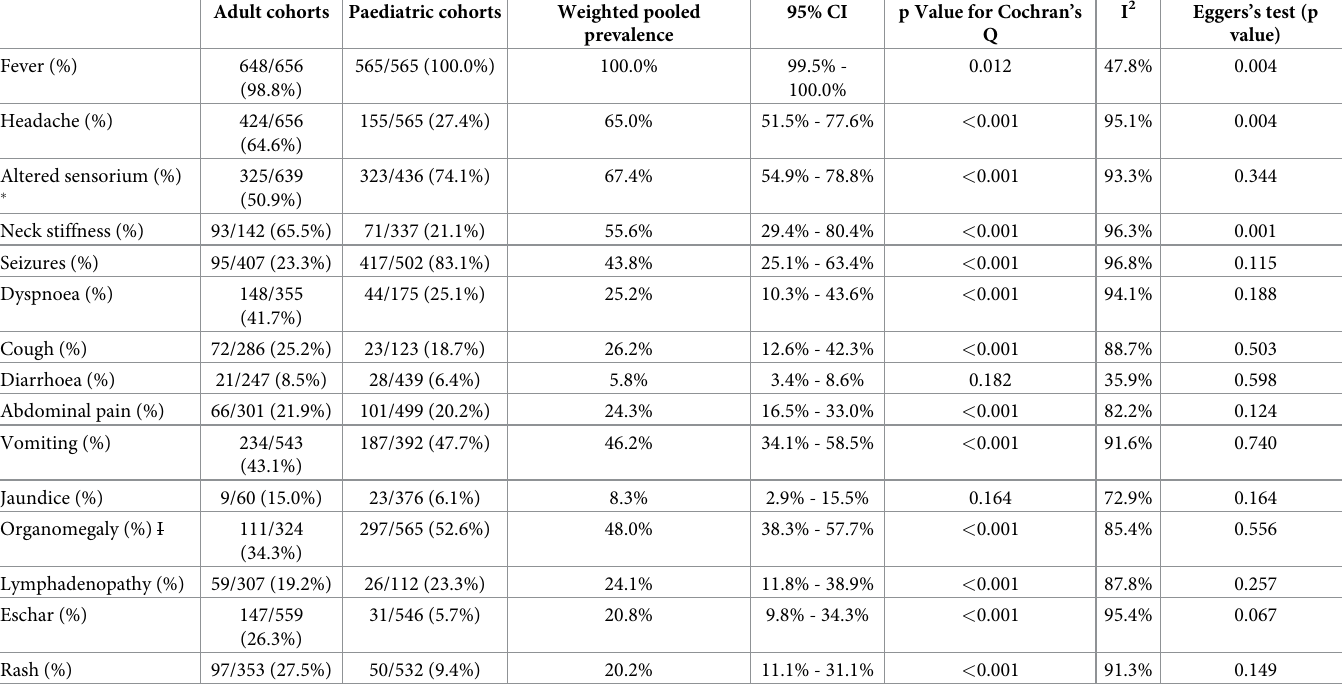
Table 2. Weighted pooled prevalence (WPP) of clinical features in patients with neurological manifestations of scrub typhus; � = Defined as general changes in brain function including abnormal Glasgow coma scale score; I = defined as hepatomegaly, splenomegaly or both Case fatality ratio. Adult cohorts Paediatric